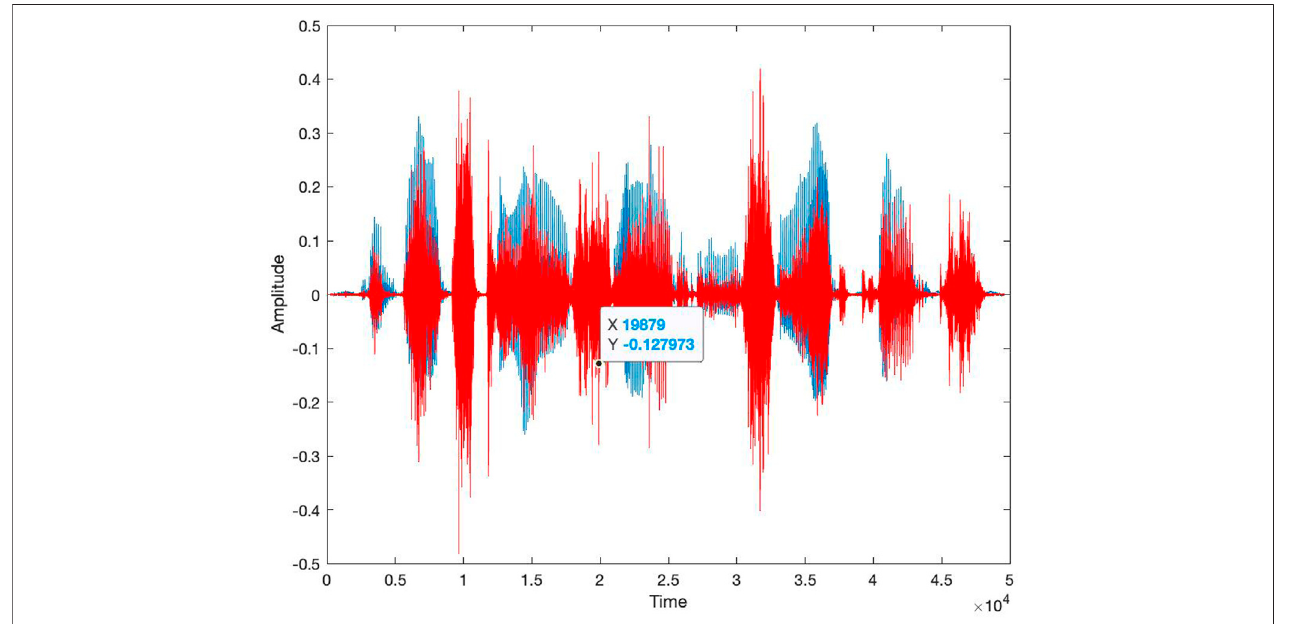
FIGURE 3 | An example of the result of applying the cochlear implant simulator to an input fi le. Blue waveform: time domain waveform of the original signal; red waveform: waveform of the signal passed through the simulator.